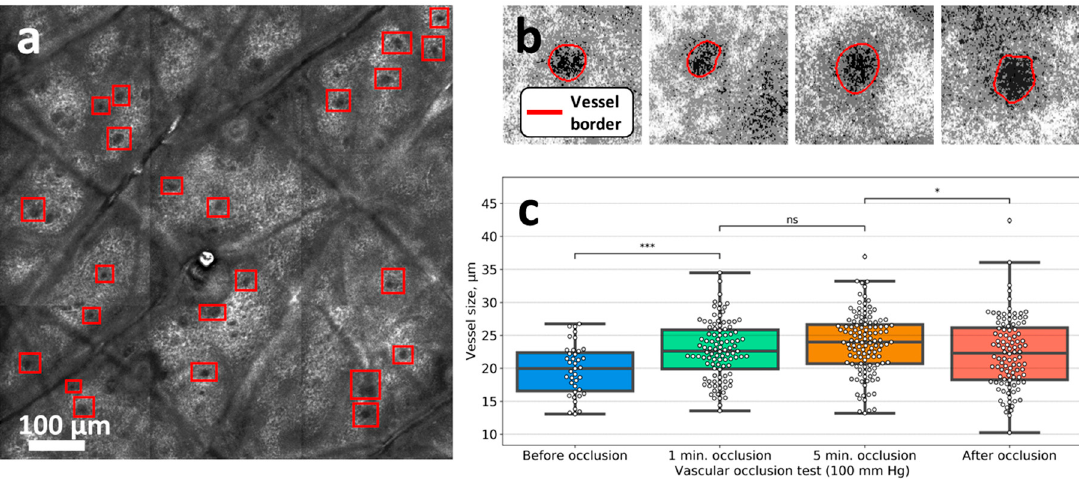
Figure 4. ( a ) CLSM image of the human forearm obtained at 50 mkm depth. The red rectangles correspond to the areas containing capillaries. ( b ) CLSM images of the dermal capillary area measured during venous occlusion. The area marked red corresponds to the capillary. ( c ) Changes in the dermal capillary sizes during venous occlusion are presented as the box plots. The dots in each box plot correspond to individual capillaries. The whiskers represent the 1.5 interquartile values range in the data. The statistical significance was estimated using Kruskal–Wallis test with Bonferroni correction (* p < 0.05; ** p < 0.01; *** p < 0.001; **** p < 0.0001, ns—not significant).